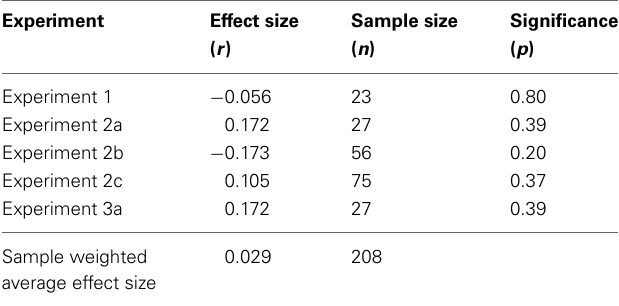
Table 5 | Meta-analysis: Correlations between mind-blanking and mind-wandering.